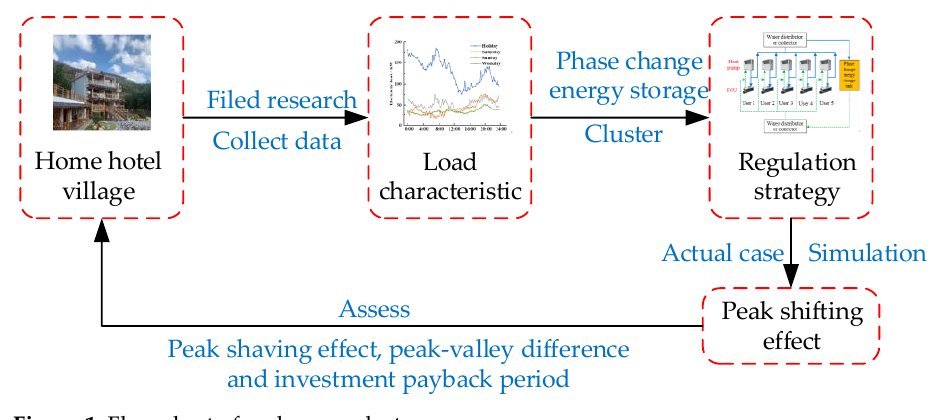
Figure 1. Flow chart of each research step.